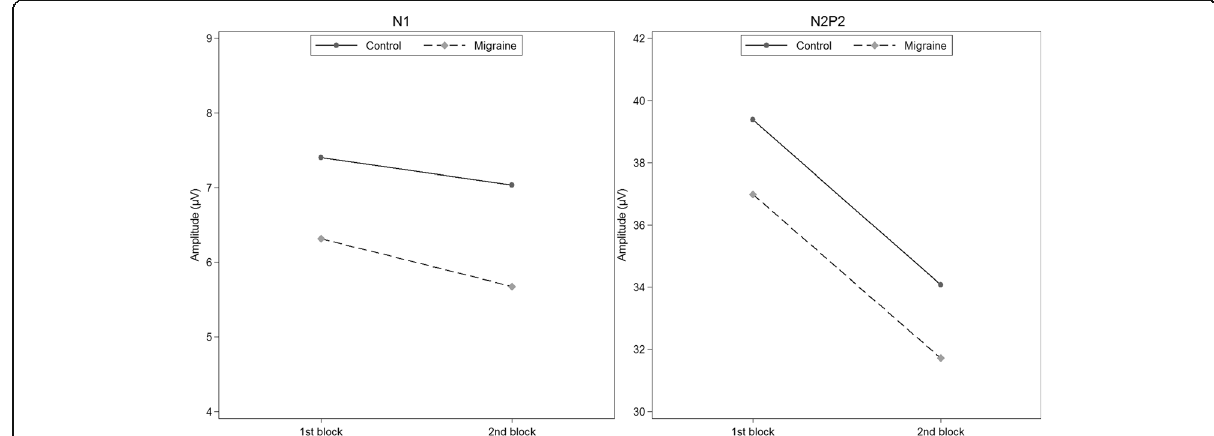
Fig. 4 Estimates of N1 (left) and N2P2-amplitude (right) habituation in interictal recordings and